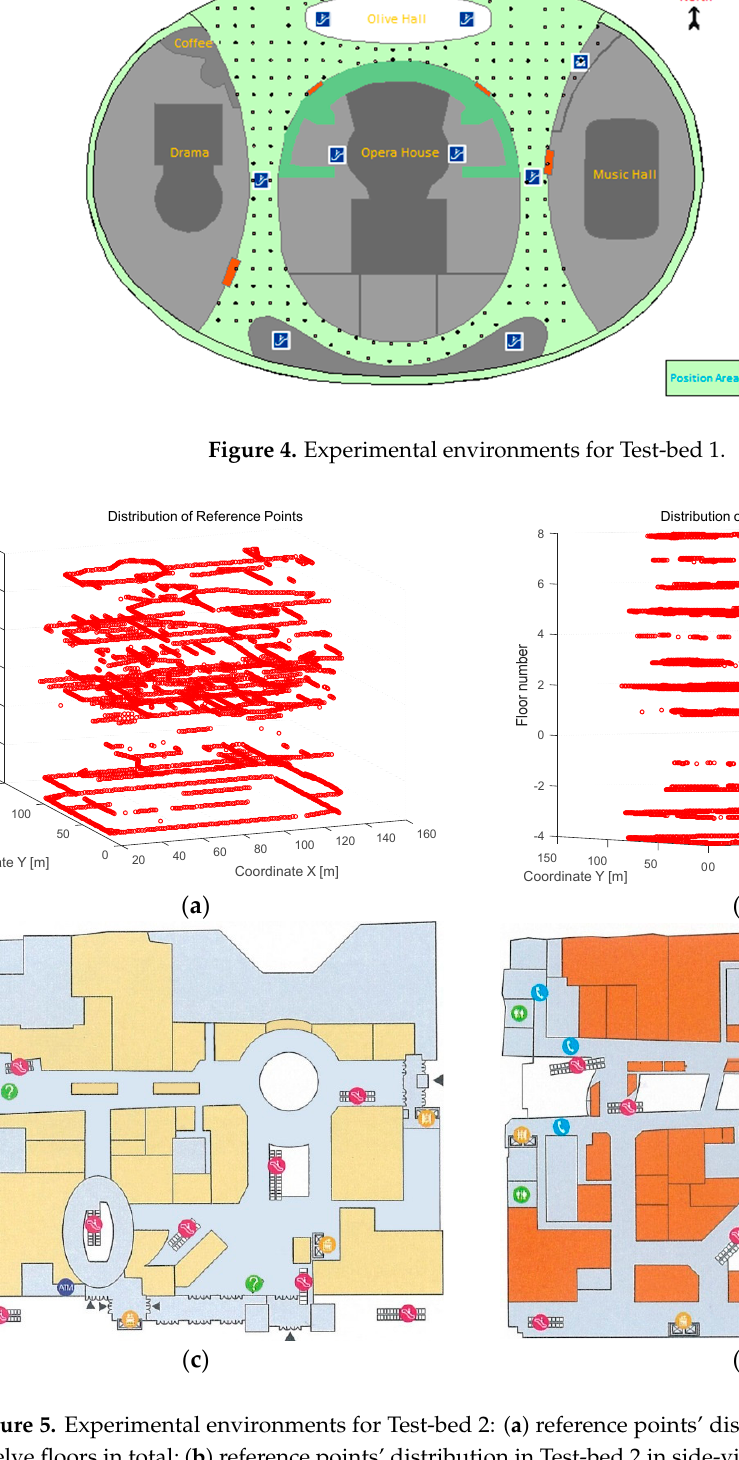
Figure 5. Experimental environments for Test-bed 2: ( a ) reference points’ distribution in Test-bed 2, twelve floors in total; ( b ) reference points’ distribution in Test-bed 2 in side-view; ( c ) the first floor of Test-bed 2 in planar graph; and ( d ) the second floor of Test-bed 2 in planar graph.